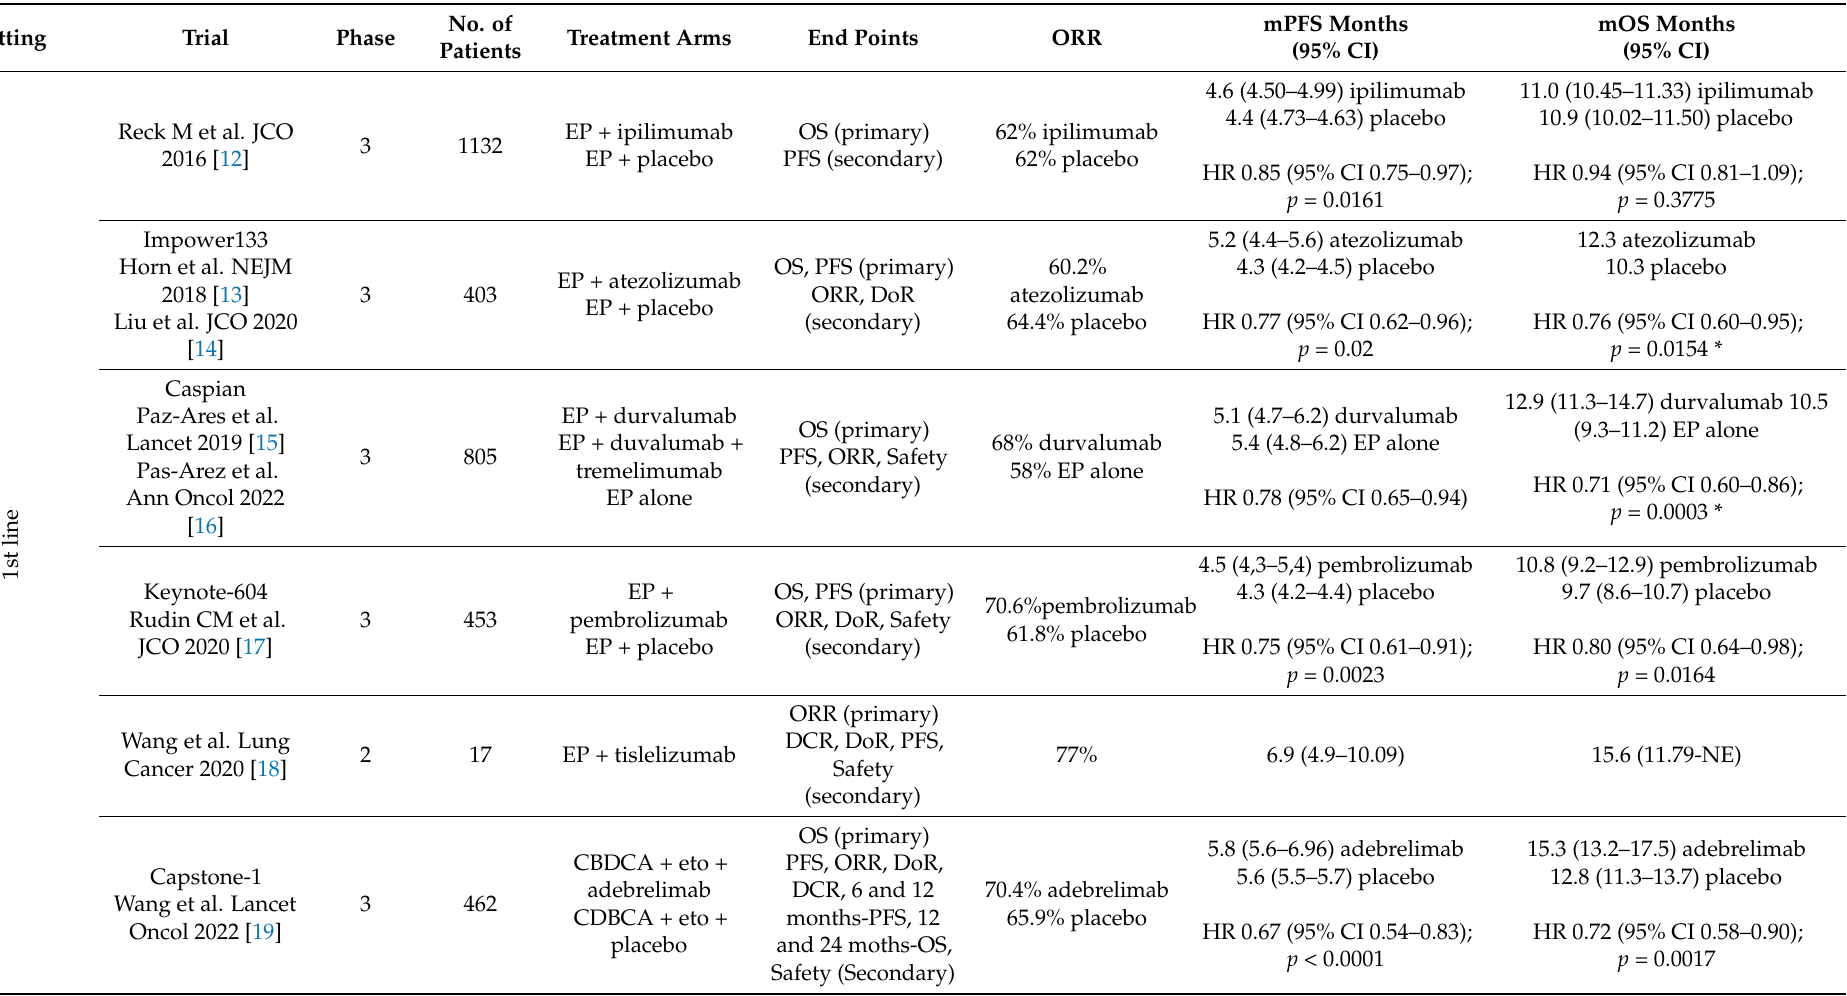
Table 1. Main clinical trials about immune checkpoint inhibitors in ES-SCLC as first, second or further lines of treatment and as maintenance after first-line platinum-based